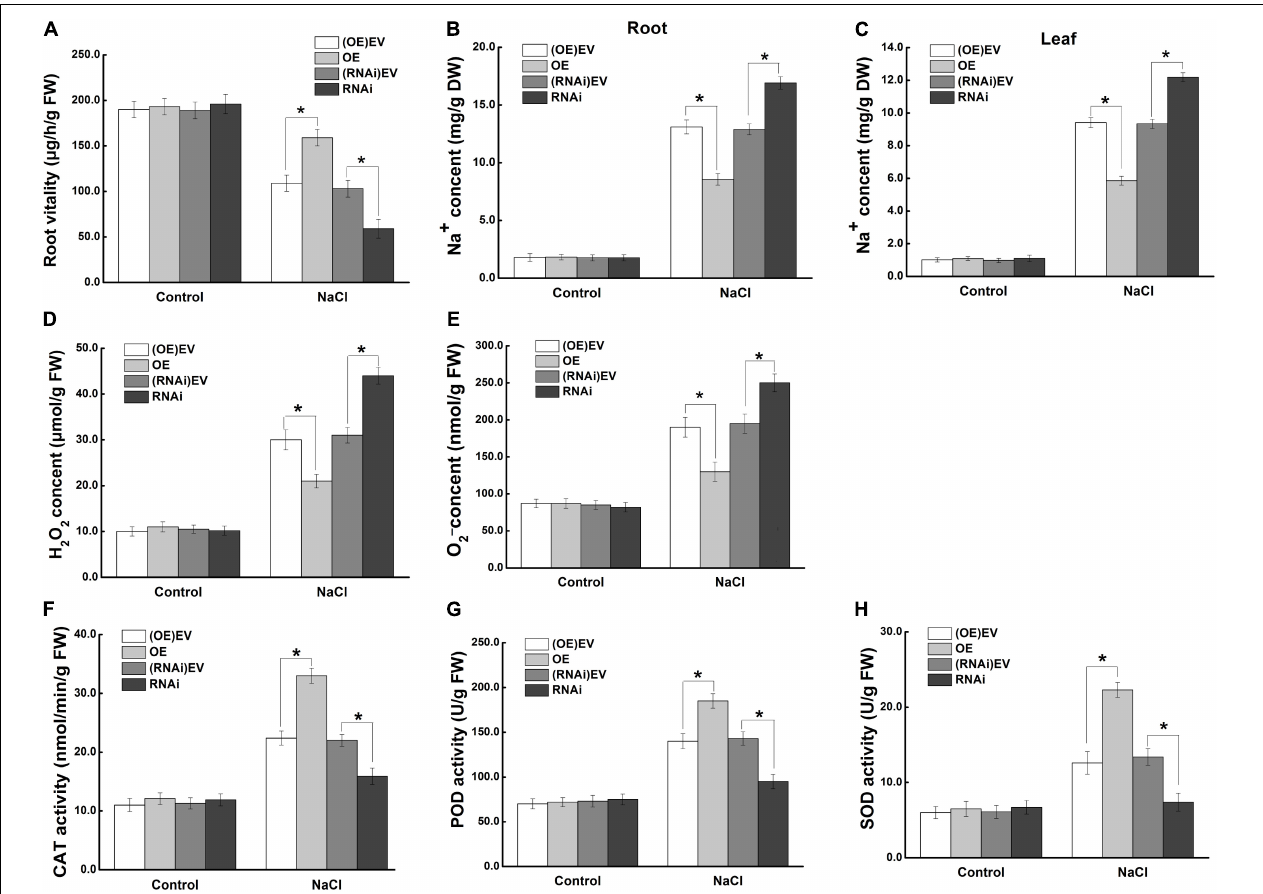
FIGURE 9 | MdCCX1 regulated Na + accumulation and antioxidant enzymes activities. (A) Root vitality. (B) Na + content in roots. (C) Na + content in leaves. Hydrogen peroxide (H 2 O 2 ) content (D) and superoxide anion (O 2 − ) content (E) in transgenic apple roots. (F–H) Enzymatic activity of antioxidant enzymes CAT (F) , POD (G) , and SOD (H) under normal and NaCl stress conditions. The values of each index are the average values of all lines in transgenic plants of the same type. Values are means of 20 replicates ± SD. * in each panel indicates values that are significantly different from the corresponding control lines at p < 0.05, using Student’s t-test .